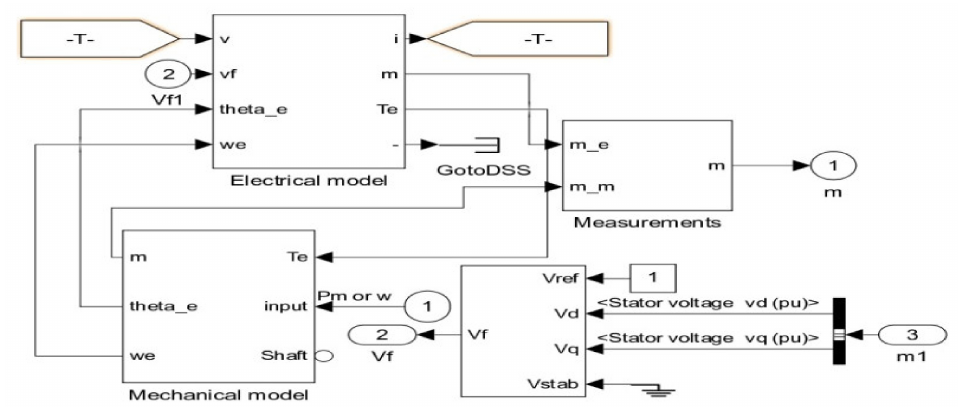
Figure 4. The control scheme of a synchronous condenser. Parameters of the WDHPS network with BESS systems are presented in Table